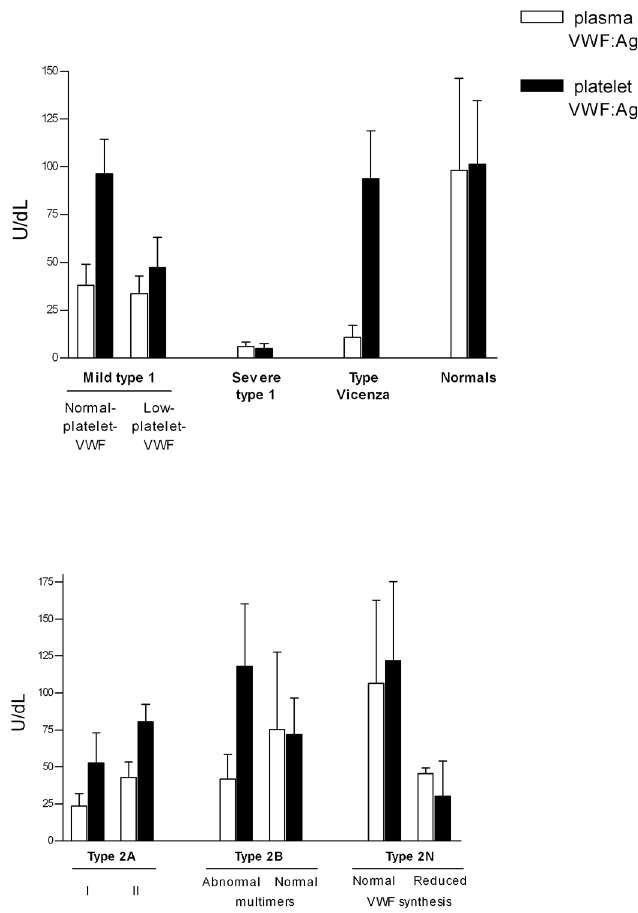
Fig 1. Mean plasma and platelet VWF in patients with quantitative (upper panel) and functional (lower panel) VWF defects. Type 1 VWD patients were divided into severe and mild cases, based on their circulating VWF levels ( < 10U/dL and < 50 U/dL, respectively). Mild type 1 patients were further grouped according to their normal or low platelet VWF content. Functional VWF defects in type 2A were separated